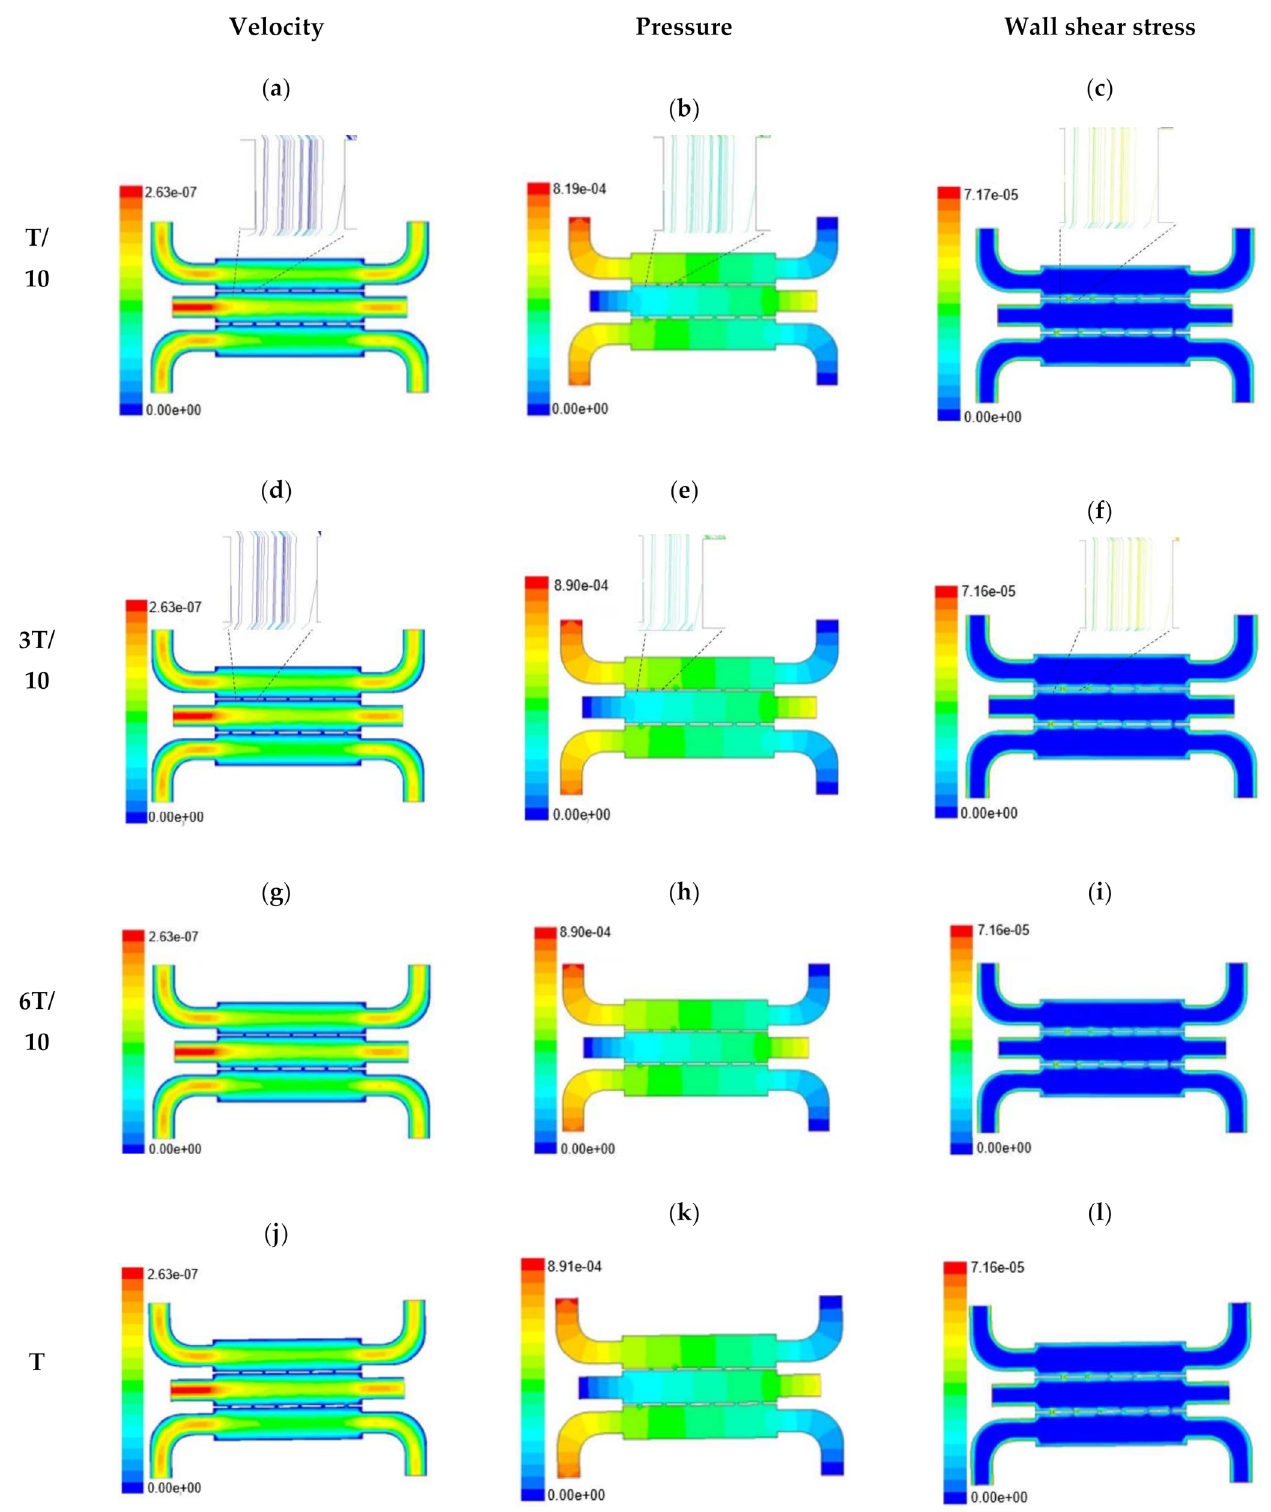
Figure 4. Numerical simulation of fluid flow inside the chip design 1 at flow rate of 10 µ L/min. The different time step was taken to understand the profile of velocity ( a , d , g , j ), pressure ( b , e , h , k ) and wall shear stress ( c , f , i , l ) along the